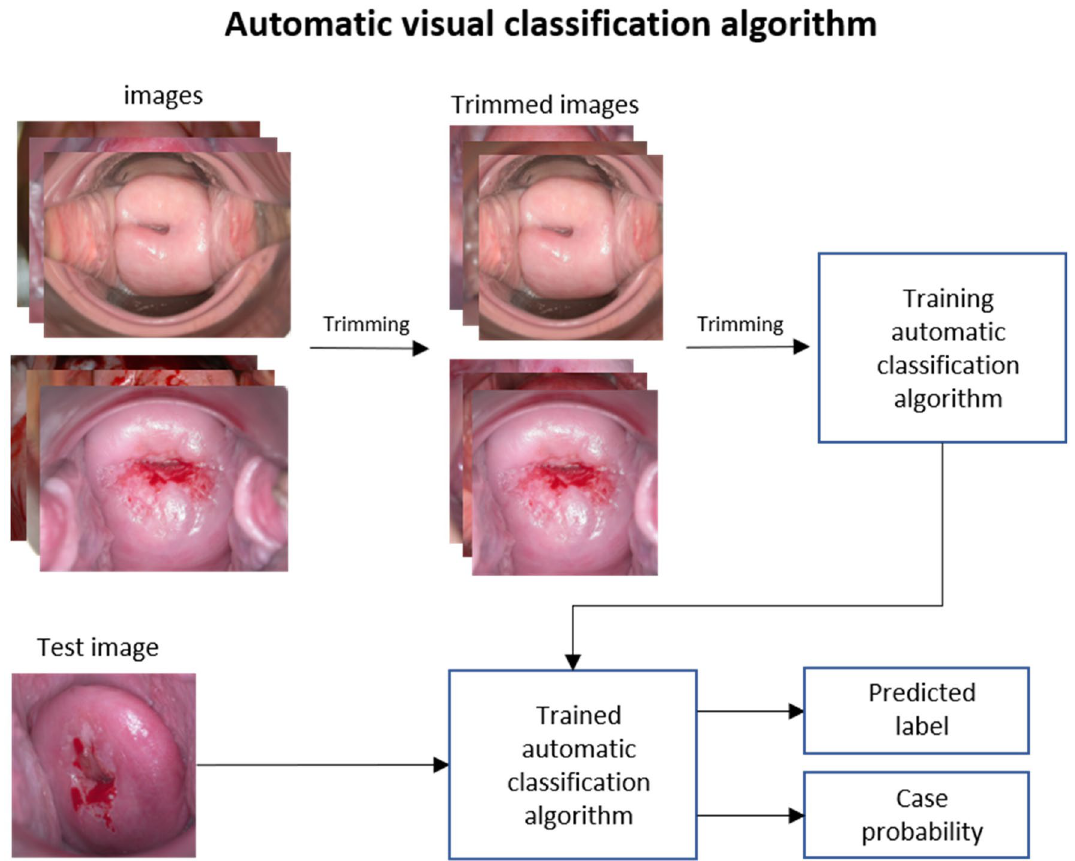
Figure 3. DL model training process for cervical cancer classification. The input images are trimmed and used as training data. The trained model then predicts test